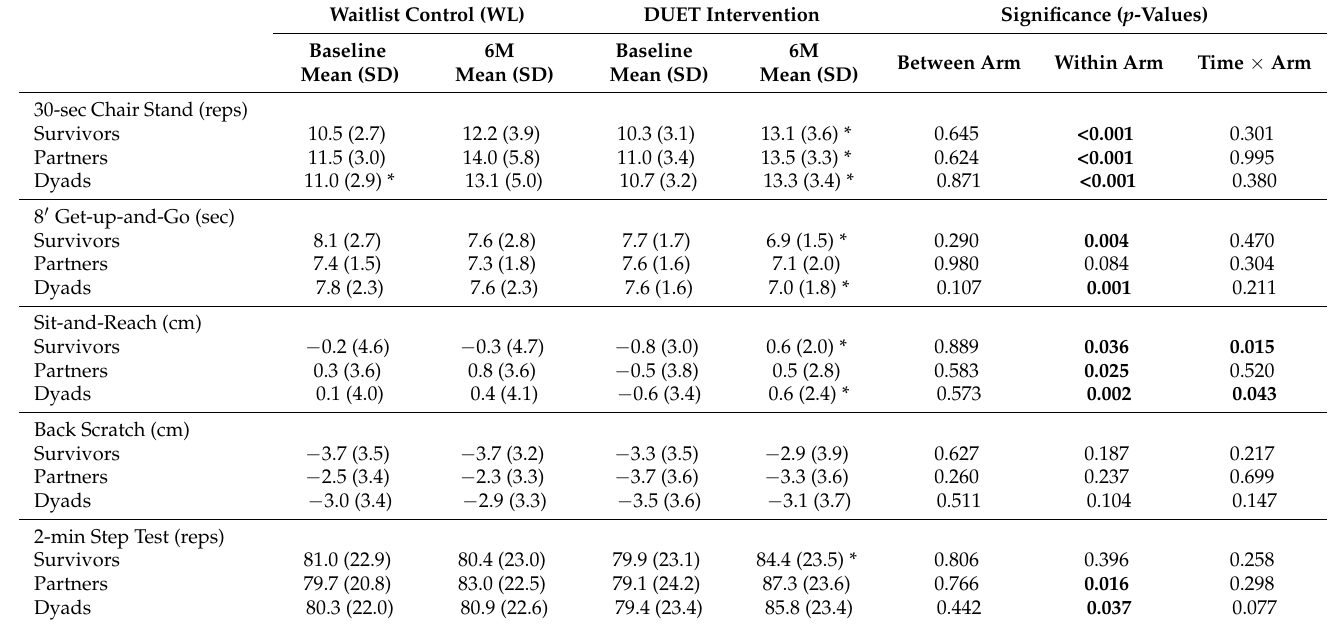
Table 3. Baseline to 6-m differences in physical performance in waitlist vs. DUET intervention study